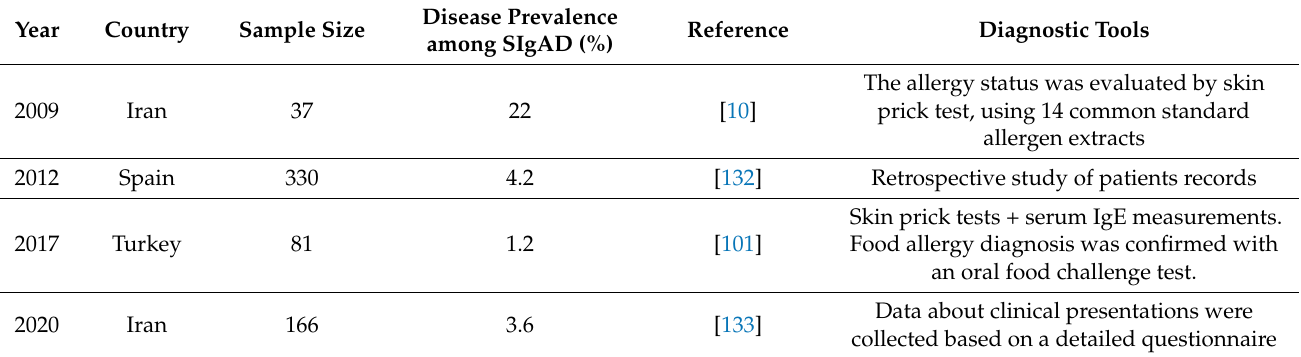
Table 1. Food allergy and